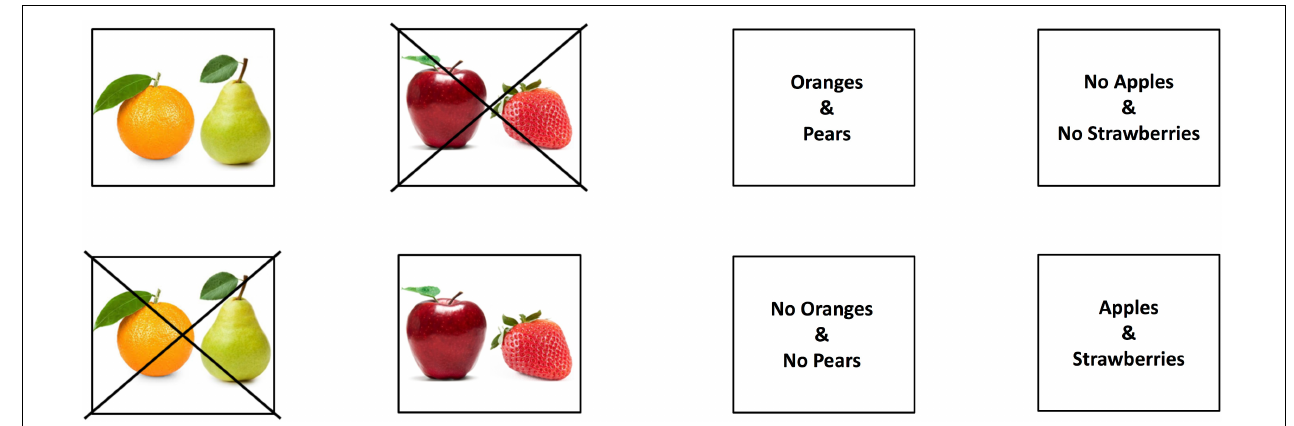
FIGURE 1 | Examples of the pictorial-based visual display used in Experiments 1 and 2 (on the left), and the word-based visual display used in Experiment 3 (on the right), for the counterfactual conditional “if there had been oranges then there would have been pears.”